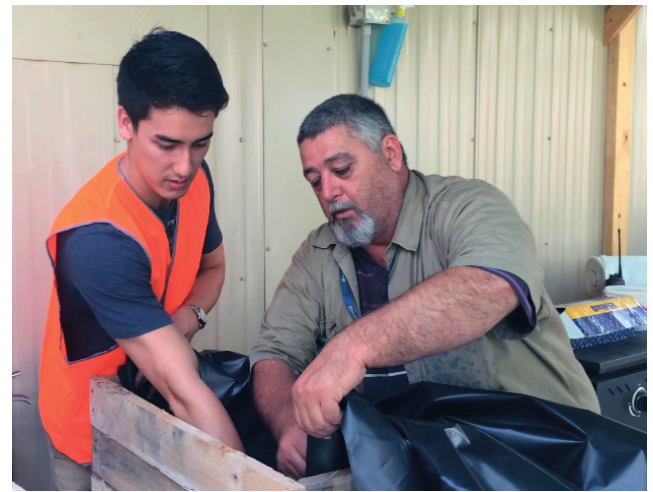
Figure 4. A foreman and apprentice working together during the working bee.